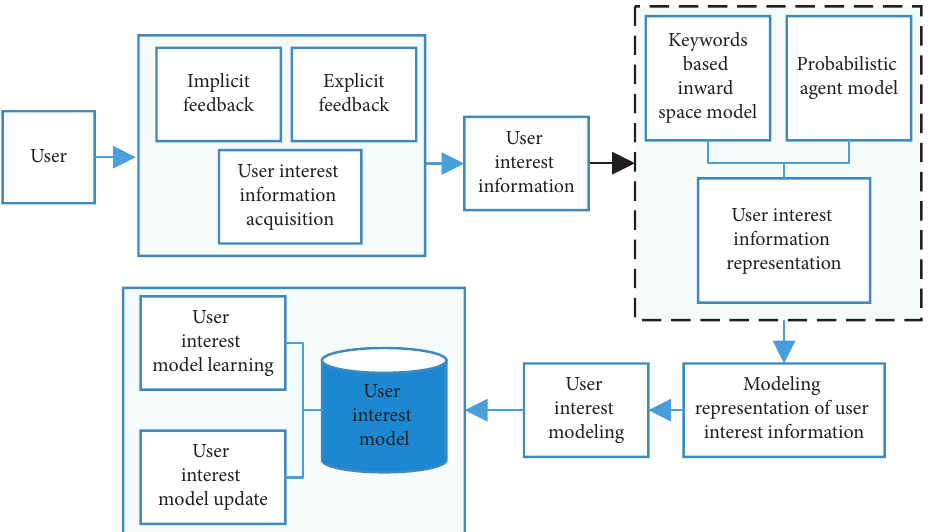
Figure 1: Selected photographic records of